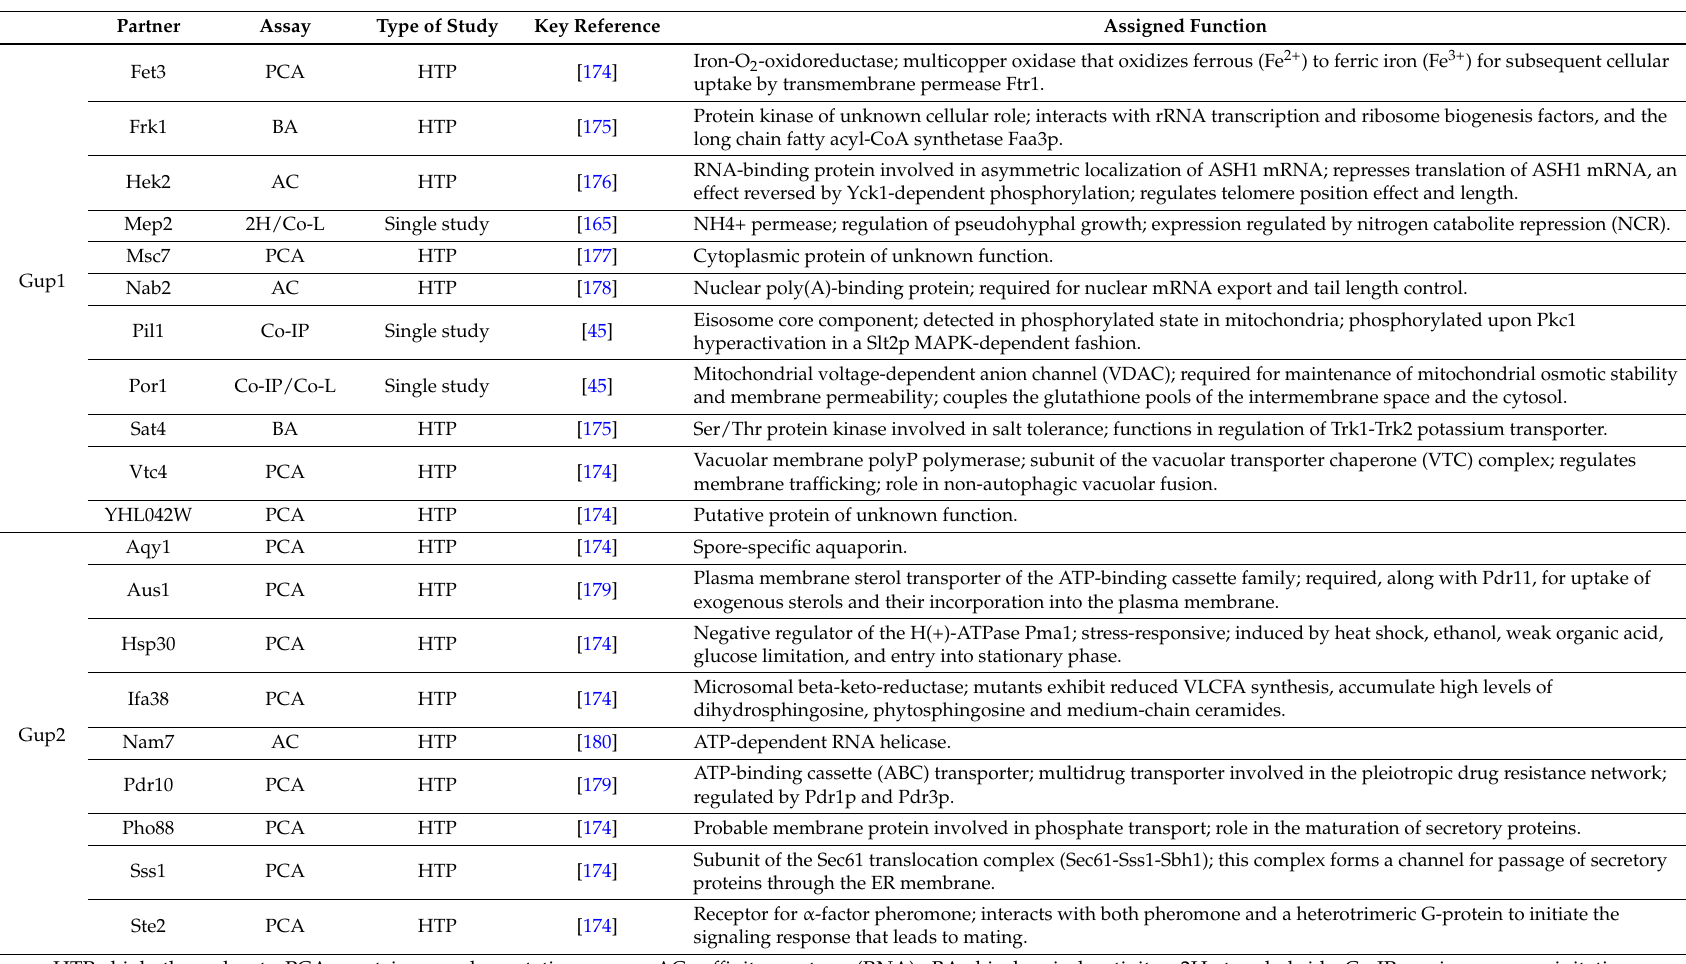
Table 3. Gup1 and Gup2 ascertained and predicted physical